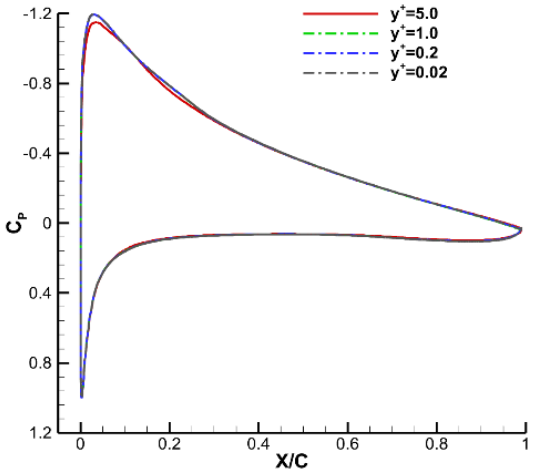
Figure 4. Comparison of pressure coefficients for SD 7003 at an angle of attack 4°.